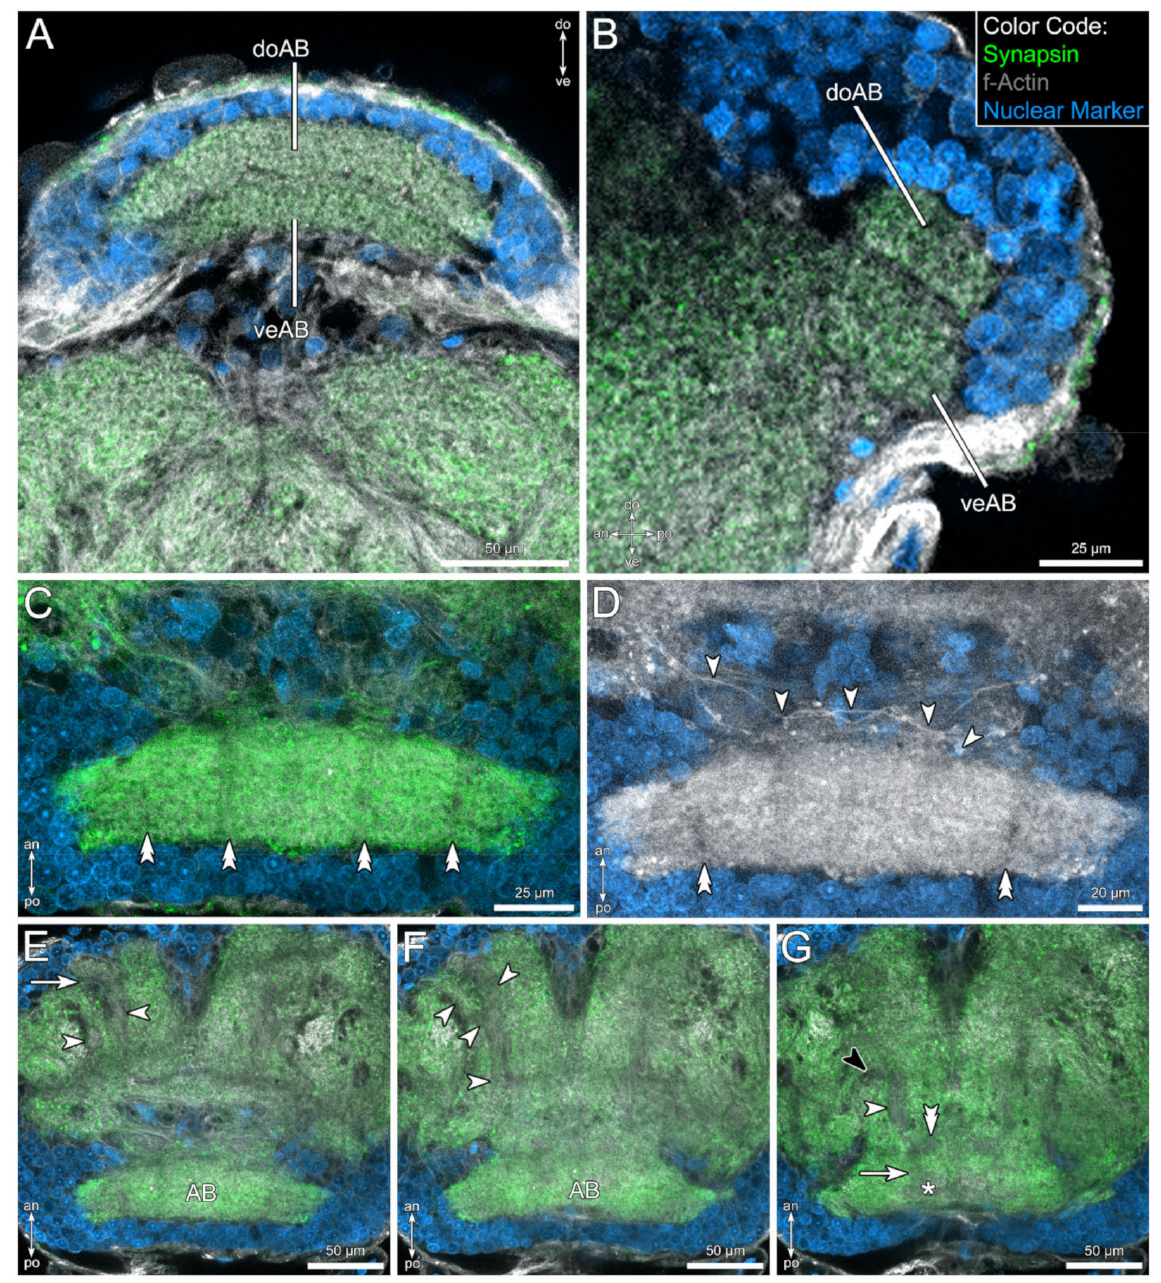
Figure 3. Neuroanatomical details of the protocerebrum in Chelifer cancroides , revealed by fluorescent labeling of synaptic regions (green), f-actin (gray), and cell bodies (blue). ( A , B ) Frontal ( A ) and sagittal view on the protocerebrum. The arcuate body (AB) is located at a postero-dorsal position and consists of a dorsal (doAB) and a ventral layer (veAB). ( C ) In horizontal view, the arcuate body is built up of several palisade-like subunits, which are separated by fiber tracts (double arrowheads in ( C ) and ( D )). ( D ) Distinct fibers (arrowheads) connect the arcuate body and contralateral protocerebral neuropils. ( E – G ) Ventral to dorsal series of the protocerebrum, showing the components of the mushroom bodies. Two fiber tracts (arrowheads in ( E )) emerge from an antero-lateral neuropil (arrow in ( E )). More ventrally both fiber tracts (arrowheads in ( F )) fuse and project further posteriorly. At a dorsal level, the fused main tract (white arrowhead in ( G )) terminates in a postero-medial lobe (double arrowhead in ( G )) close to the midline. A lateral tract leaves the main tract (black arrowhead in ( G )). It seems, that the main tract projects further posteriorly (arrow in ( G )) and terminates in a second lobe (asterisk in ( G )) in close vicinity to the arcuate body. Other abbreviations: an: anterior; do: dorsal; po: posterior; ve: